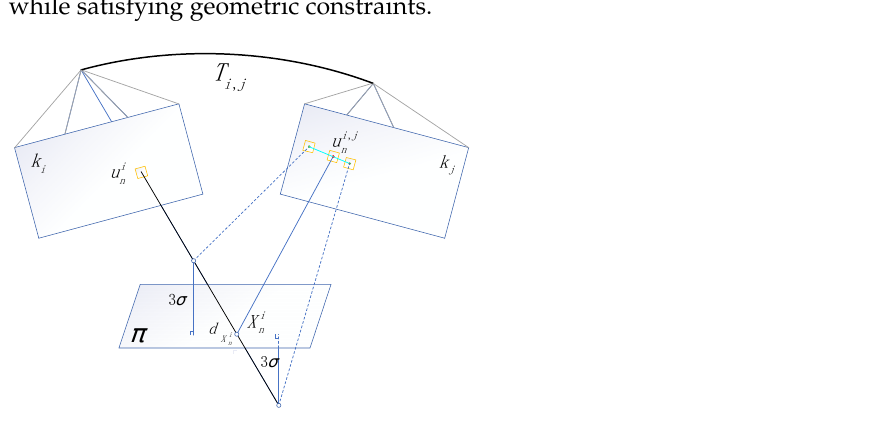
Figure 6. Under the guarantee of conforming to the geometric constraints, the spatial coordinates of feature points are optimized by minimizing the photometric error. The projection point of the feature point X i n on the keyframe k i is u i n , and the projection point on other keyframes k j is marked as u i , j n . The feature point X i n moves along the direction of its depth to minimize the photometric error of its projection on all other keyframes. In addition, the distance between the feature point X i n and the estimation spatial plane π remains less than 3 σ , ensuring that the geometric constraints are always met.